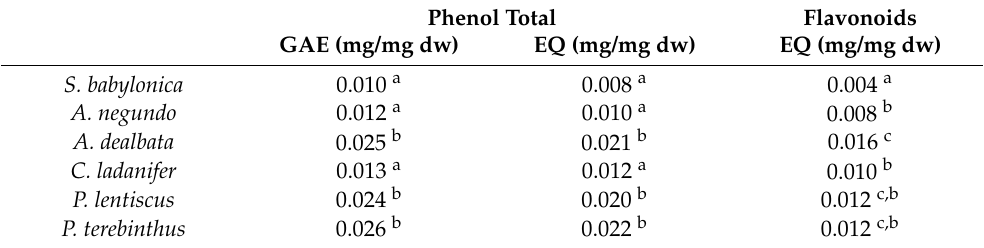
Table 1. Total phenols and flavonoids in the extracts of selected species. n = 3. Phenol Total Flavonoids GAE (mg/mg dw) EQ (mg/mg dw) EQ (mg/mg dw) 0.010 a 0.008 a 0.004